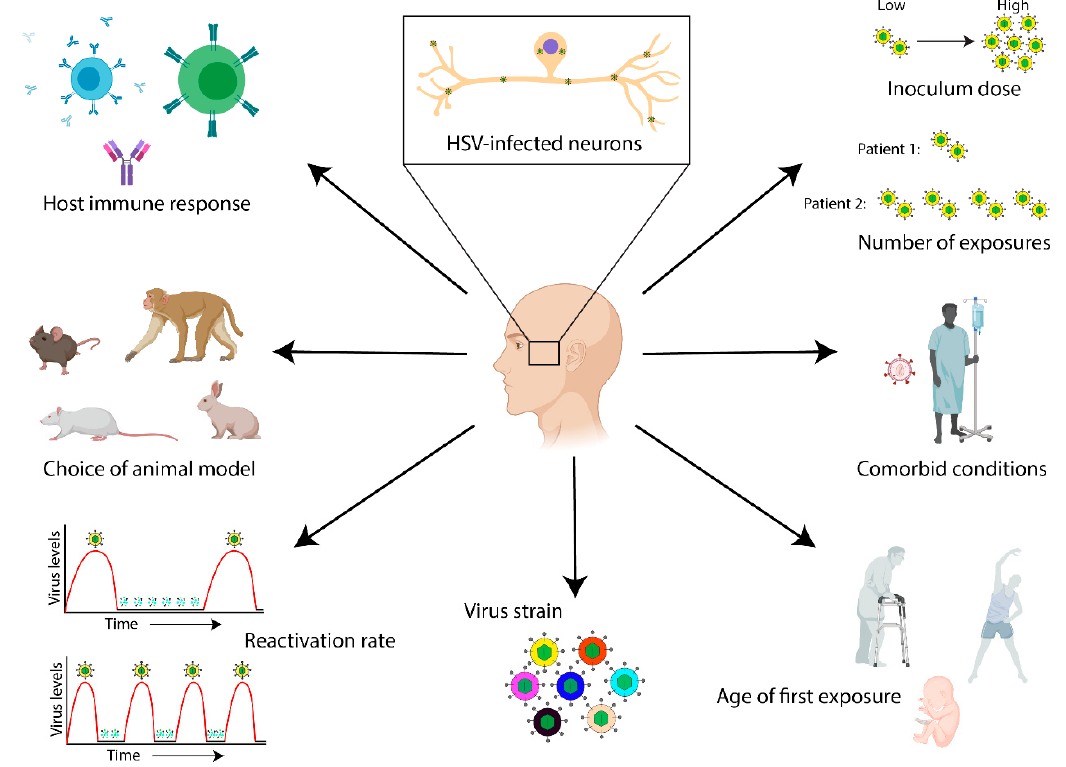
Figure 1. Persistent infection with herpes simplex virus 1 (HSV-1) and Alzheimer’s disease (AD): Opportunities for future research. Current evidence suggests that there is an association between HSV-1 infection and the development of AD later in life. However, a number of knowledge gaps exist in our understanding of the host- and virus-specific factors that may contribute to disease manifestation. Different elements may influence HSV-1 latency, reactivation, and disease outcomes in both natural and experimental settings. These variables should be taken into consideration when interpreting data, and in discussing the interactions between HSV-1 and AD development. These variables include (counter-clockwise from top left): Host immune responses and immune control; Choice of animal model; Reactivation rate differences between patients; Genetic differences between HSV-1 isolates or strains; Age at first exposure; Comorbid conditions (e.g., HIV infection, chronic obstructive pulmonary disease, etc.); Environmental influences, such as viral dose and number of exposures. Immune cell, animal, and host illustrations from Biorender.com.